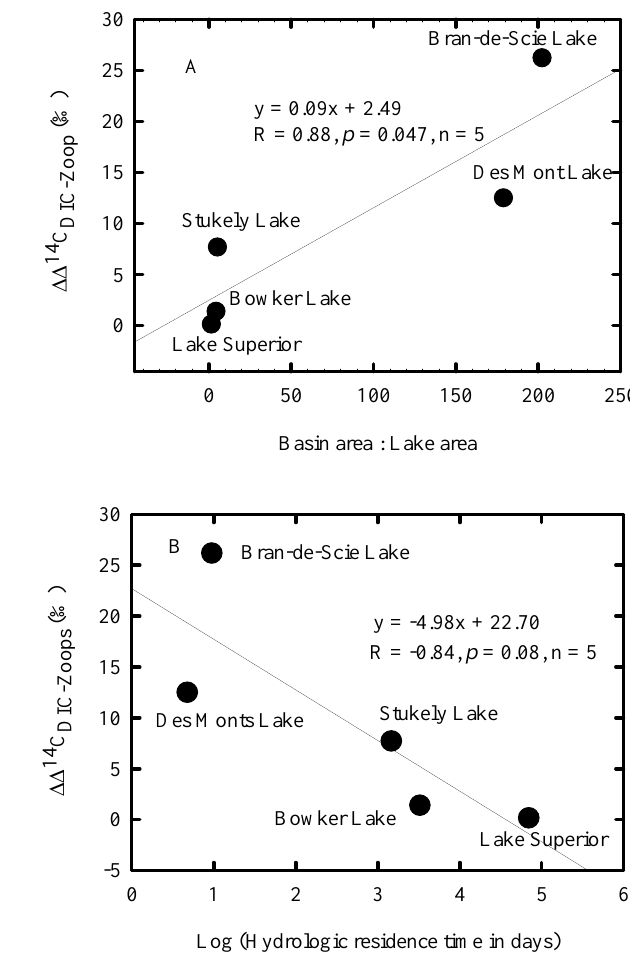
Figure 4. Fig. 4. The relationship between 1 14 C of zooplankton and (A) 1 14 C of DIC, and (B) 1 14 C of POC. These comparisons show that Fig. 5. Relationship between the difference of 1 14 C values of DIC Figure 5. the radiocarbon signatures of zooplankton are largely determined and zooplankton, and (A) ratio of basin area to lake surface area, by those of DIC, and hence algal carbon from recent photosynthesis and (B) hydrologic residence time of the various lakes. Although within the lake. For Lake Superior, two points, the average isother- marginally significant correlation ( p = 0 . 08) is observed between mal values and average stratification values, were used in order to 11 14 C DIC-Zoop and hydrologic residence time, these two plots not bias the trends. generally illustrate that zooplankton support by allochthonous or- ganic carbon is related to variables that indicate terrestrial